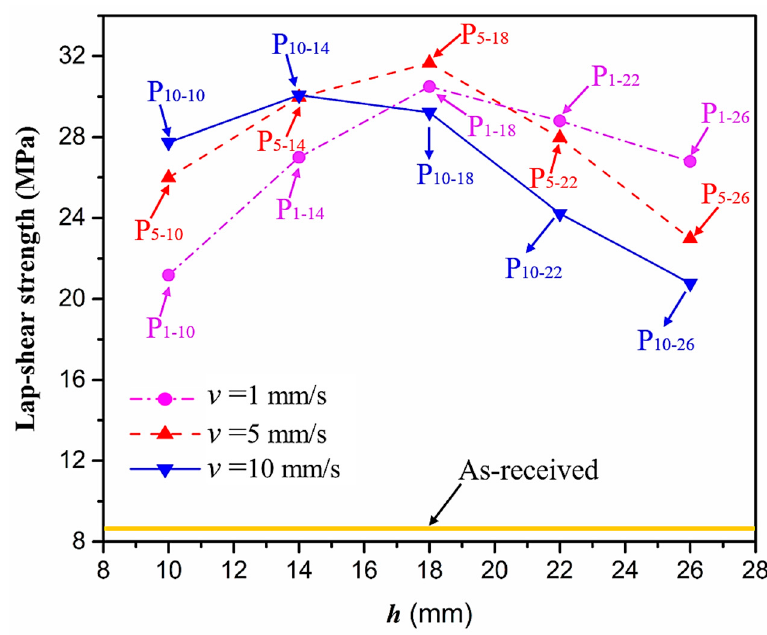
Figure 5. The lap-shear strength of adhesive-bonded CFRP joints as a function of the nozzle speed ( v ) and the nozzle distance ( h ).